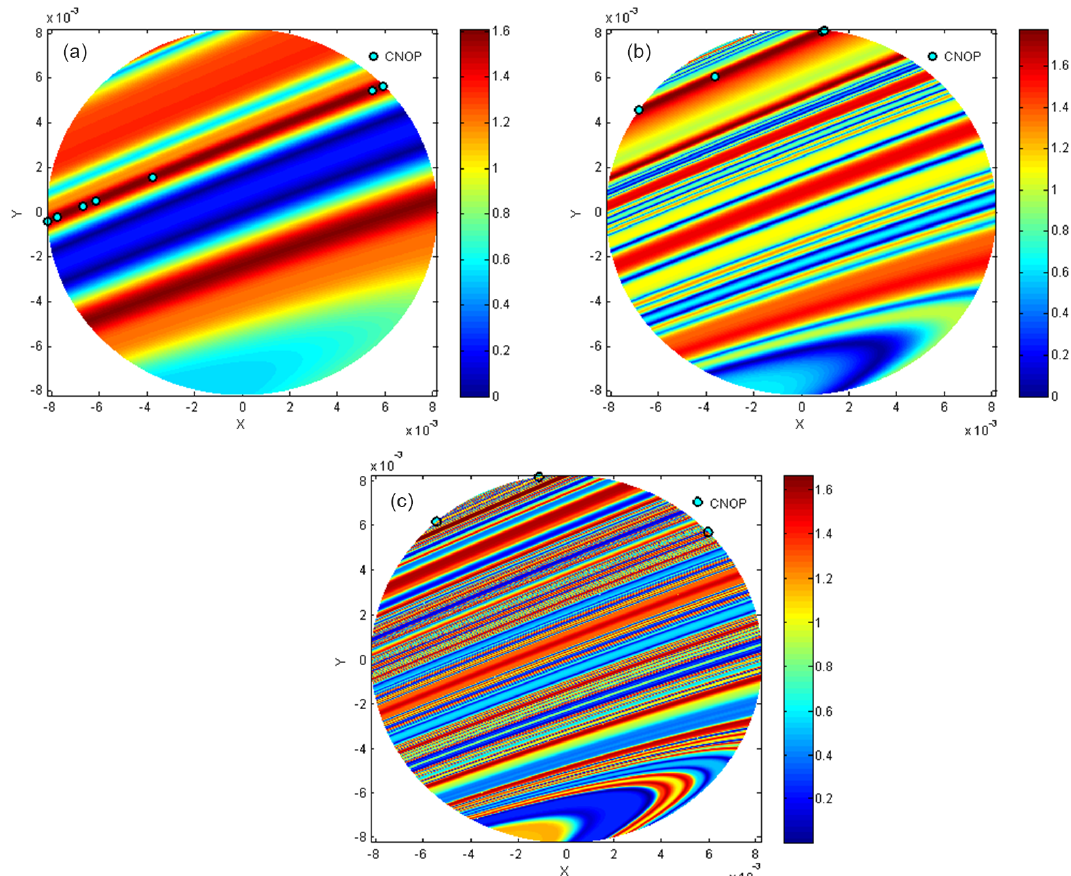
Figure 7. The distribution of OFVs at the prediction times 15 (cid:49)t (the left of the upper panel), 18 (cid:49)t (the right of the upper panel) and 22 (cid:49)t (the lower panel), where dots denote CNOPs captured by PSO-CNOP.